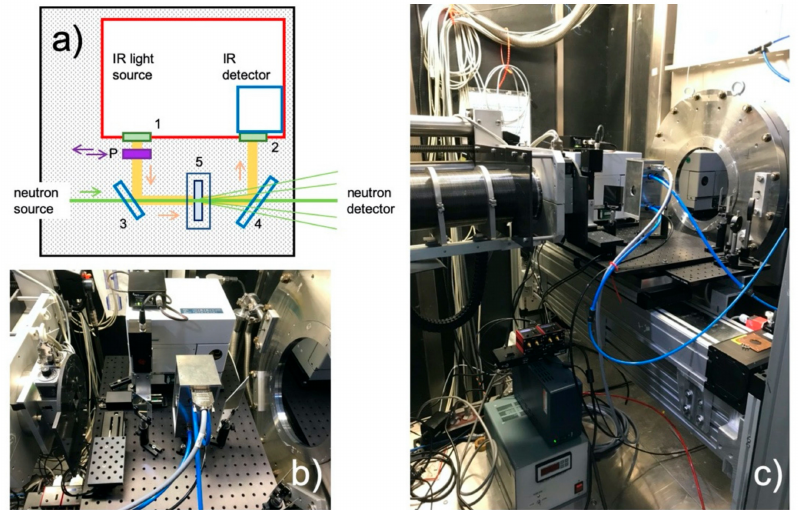
Figure 1. Schematic presentation ( a ) and detailed ( b ) and general ( c ) views of the new operational setup for in situ FTIR analysis simultaneous with the SANS investigation using the KWS-2. The numbers indicate the main components, which can be identified in the photos on the ( b , c ) panels: the outlet and inlet beam ports (1,2), the windows (3,4), and the new ancillary equipment (5) for the con- trol of the temperature on the sample (in-house designed and produced Peltier-based thermostated cuvette holder), while P indicates the IR